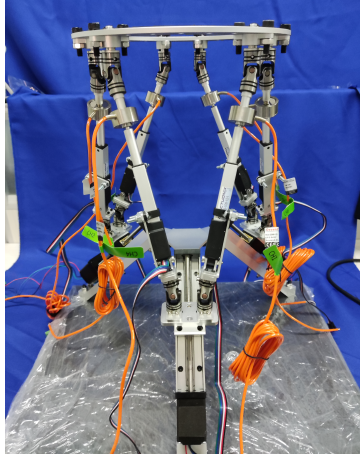
Figure 10. Prototype of the